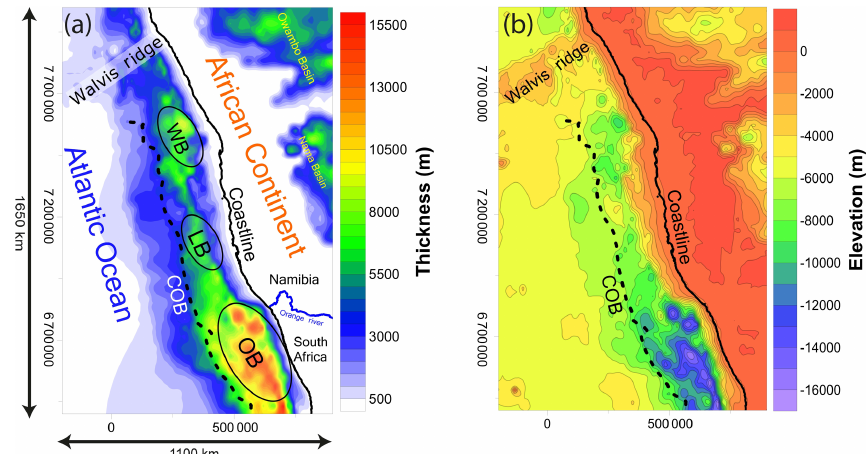
Figure 2. 3-D structural model of the SW African passive margin: (a) cumulative thickness map of sediments including offshore Cretaceous– Cenozoic thick sedimentary basins and onshore Proterozoic Owambo and Nama basins; (b) depth to top basement (COB: continent–ocean boundary, WB: Walvis Basin, LB: Lüderitz Basin, OB: Orange Basin, UTM: WGS84, zone 33S).